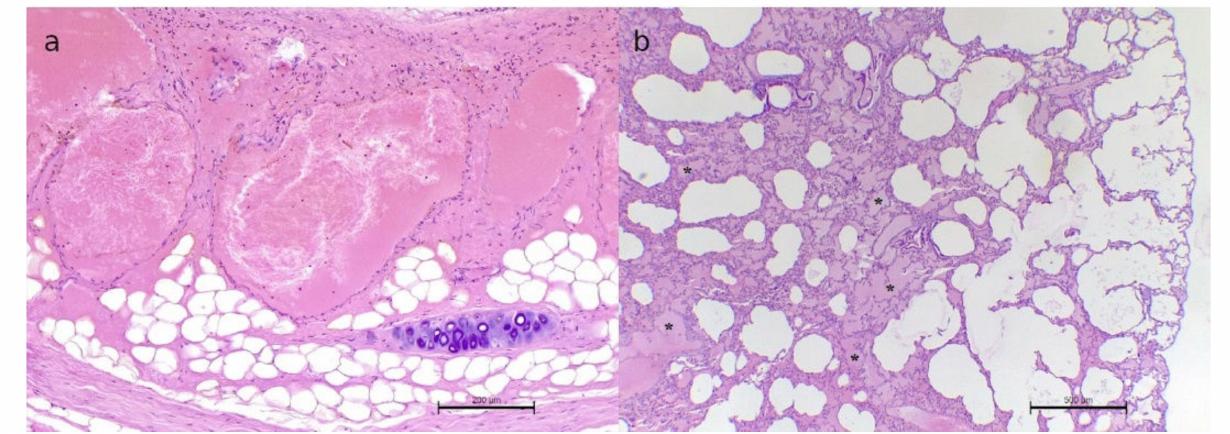
Figure 2. The histopathologic examination. ( a ). Tracheal hemangioma. Multiple vascular lacunae filled with erythrocytes and separated by stromal septa are visible. H&E staining. 100 × . ( b ). Lung’s emphysema (empty spaces) and edema (asterisks) are recognizable and scattered in the pulmonary parenchyma. H&E staining. 40 ×